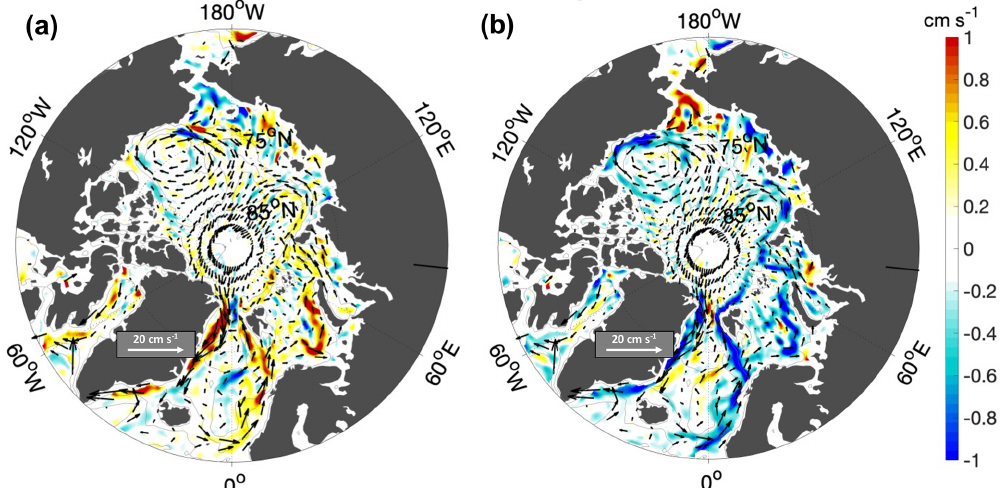
Figure 15. Average ( u g ,v g ) fields over the (a) winter months January–February–March and the (b) summer months June–July–August. Bathymetry contours are drawn at 100, 1000 and 2500m depth. Arrows and colors are to be interpreted as described for Fig.